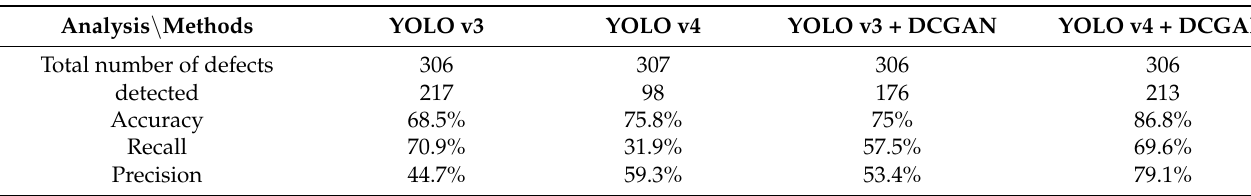
Table 4. Calculated results.